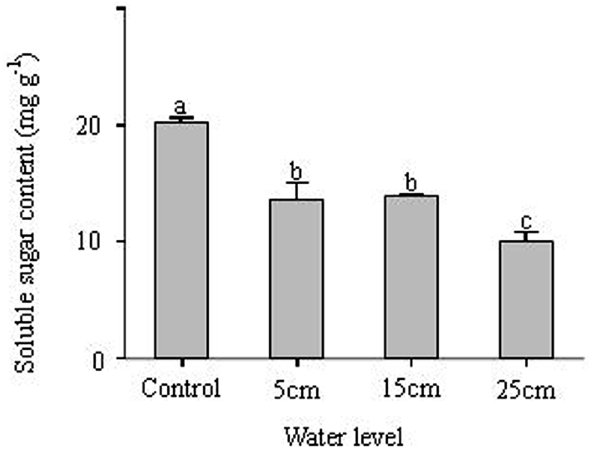
Fig 6. Soluble contents of Carex schmidtii in different treatments (one control: 0 cm water level, and three submerged conditions: 5 cm, 15 cm. and 25 cm water level). Different letters indicate significant differences among treatments ( P <